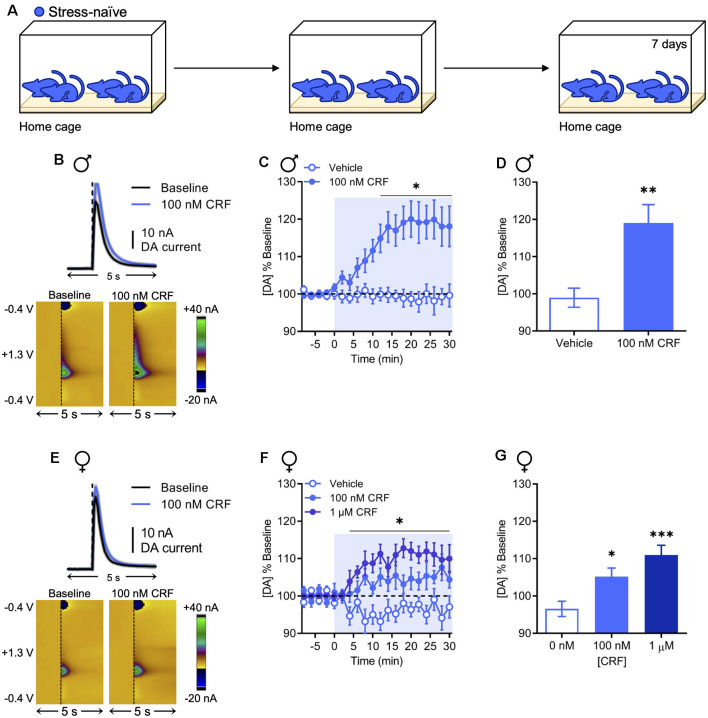
Corticotropin-releasing factor (CRF) increases dopamine release in the nucleus accumbens (NAc) in stress-naïve males and females. (A) In the stress-naïve experimental group, mice remained in their home cage for the duration of the experiment. (B) Representative dopamine release evoked by electrical stimulation (dashed line) before and after application of 100 nM CRF to a NAc brain slice collected from a stress-naïve male (mean ± SEM for five consecutive stimulations, top) and corresponding two-dimensional plots depicting changes in faradaic current (pseudocolor) with time as the abscissa and applied potential as the ordinate (bottom). (C) Baseline-normalized mean peak amplitude of electrically evoked dopamine release over time in response to vehicle (n = 9) or 100 nM CRF (n = 11) application to NAc slices from stress-naïve males. (D) Baseline-normalized mean peak amplitude of dopamine release 20–30 min after vehicle (n = 9) or 100 nM CRF (n = 11) application to NAc slices from stress-naïve males. (E) Representative dopamine release evoked by electrical stimulation (dashed line) before and after application of 100 nM CRF to a NAc brain slice from a stress-naïve female (mean ± SEM for five consecutive stimulations, top) and corresponding color plots (bottom). (F) Baseline-normalized mean peak amplitude of electrically evoked dopamine release over time in response to vehicle (n = 10), 100 nM CRF (n = 8), or 1 μM CRF (n = 8) application to NAc slices from stress-naïve females. (G) Baseline-normalized mean peak amplitude of dopamine release 20–30 min after vehicle (n = 10), 100 nM CRF (n = 8), or 1 μM CRF (n = 8) application to NAc slices from stress-naïve females. Error bars, SEM. *P < 0.05, **P < 0.01, ***P < 0.001 vs. vehicle.